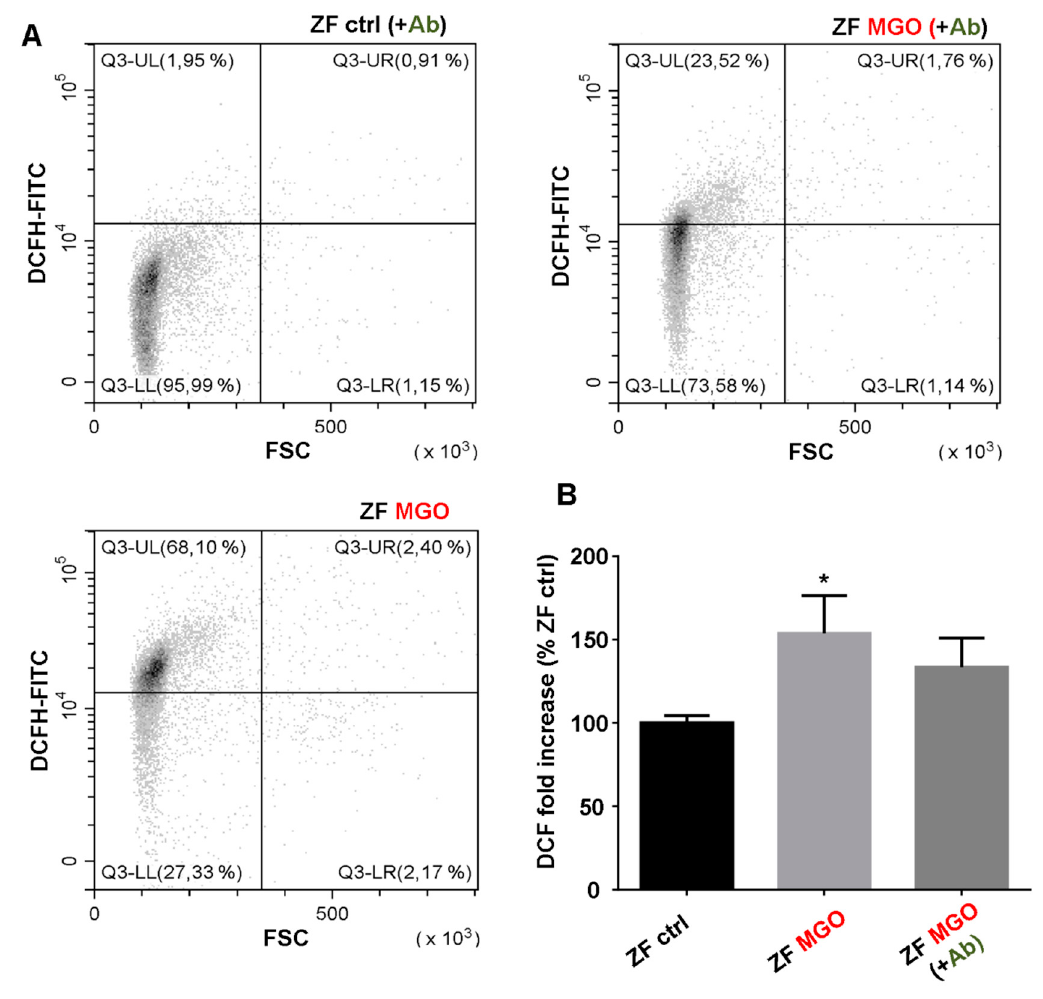
Figure 5. Antioxidant e ff ect of Antirhea borbonica on red blood cells of MGO-induced oxidative stress in zebrafish. Intracellular ROS levels in zebrafish erythrocytes were investigated by flow cytometry using DCFH-DA probe. ( A ) Typical FACS dot plots FSC vs. DCFH-FITC after red blood cells staining of zebrafish (ZF) ctrl, ZF MGO and ZF MGO + Ab . ( B ) Average fold increase in DCFH fluorescence compared with RBC of control. Data are means ± SEM of three independent experiments. * E ff ect of MGO (vs. ZF ctrl), * p < 0.05.